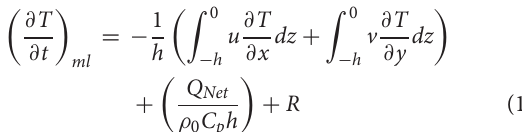
the anomalous mixed layer heat budget